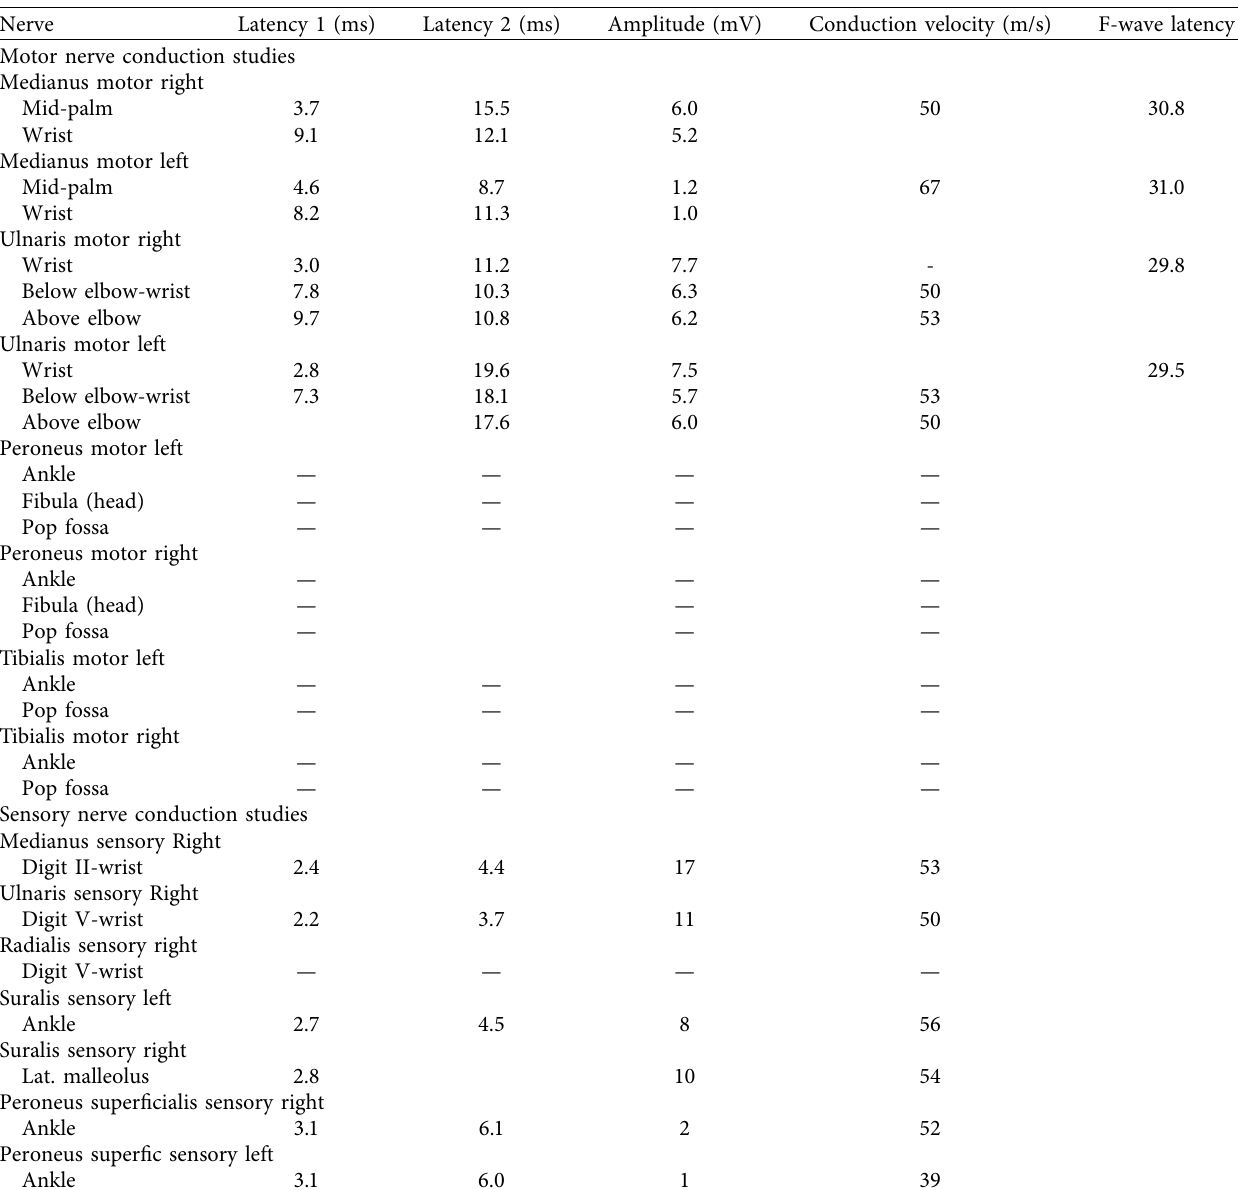
Table 1: Motor and sensory nerve conduction